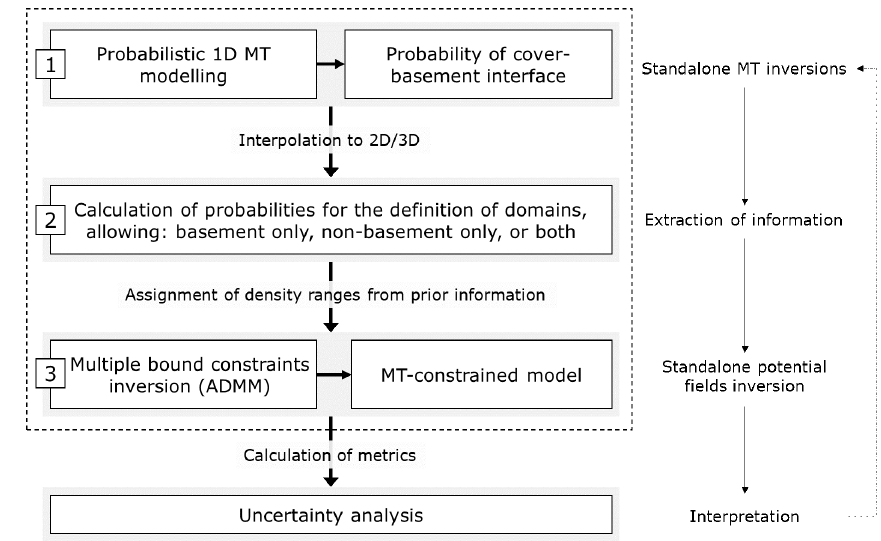
Figure 1. MT–magnetic integration workflow summary showing the role of the different